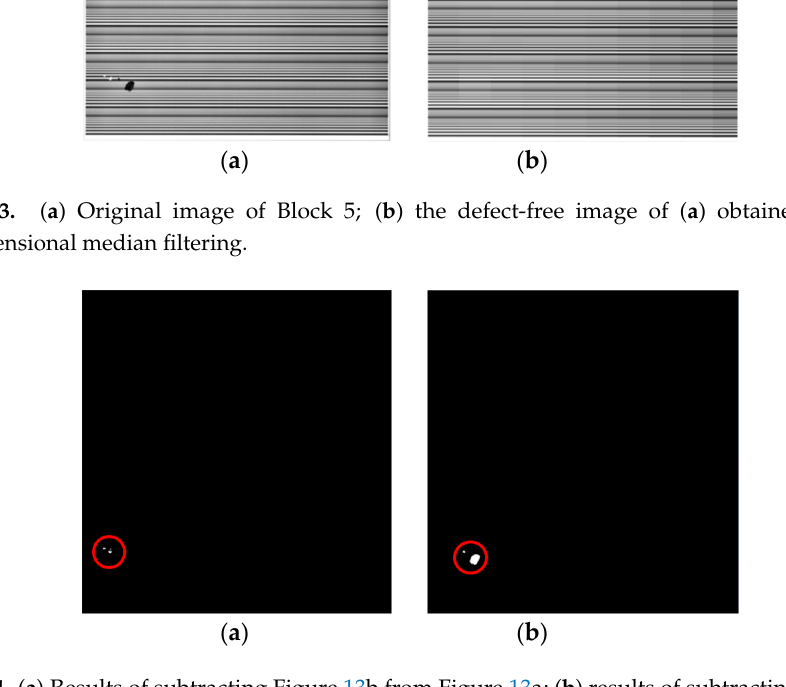
Figure 14. ( a ) Results of subtracting Figure 13b from Figure 13a; ( b ) results of subtracting Figure 13a from Figure 13b.